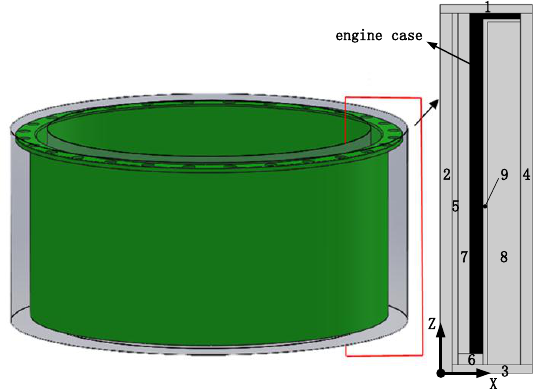
Figure 15. Radial section of the blank (The order of material removal was 1-2-3-4-5-6-7-8-9).